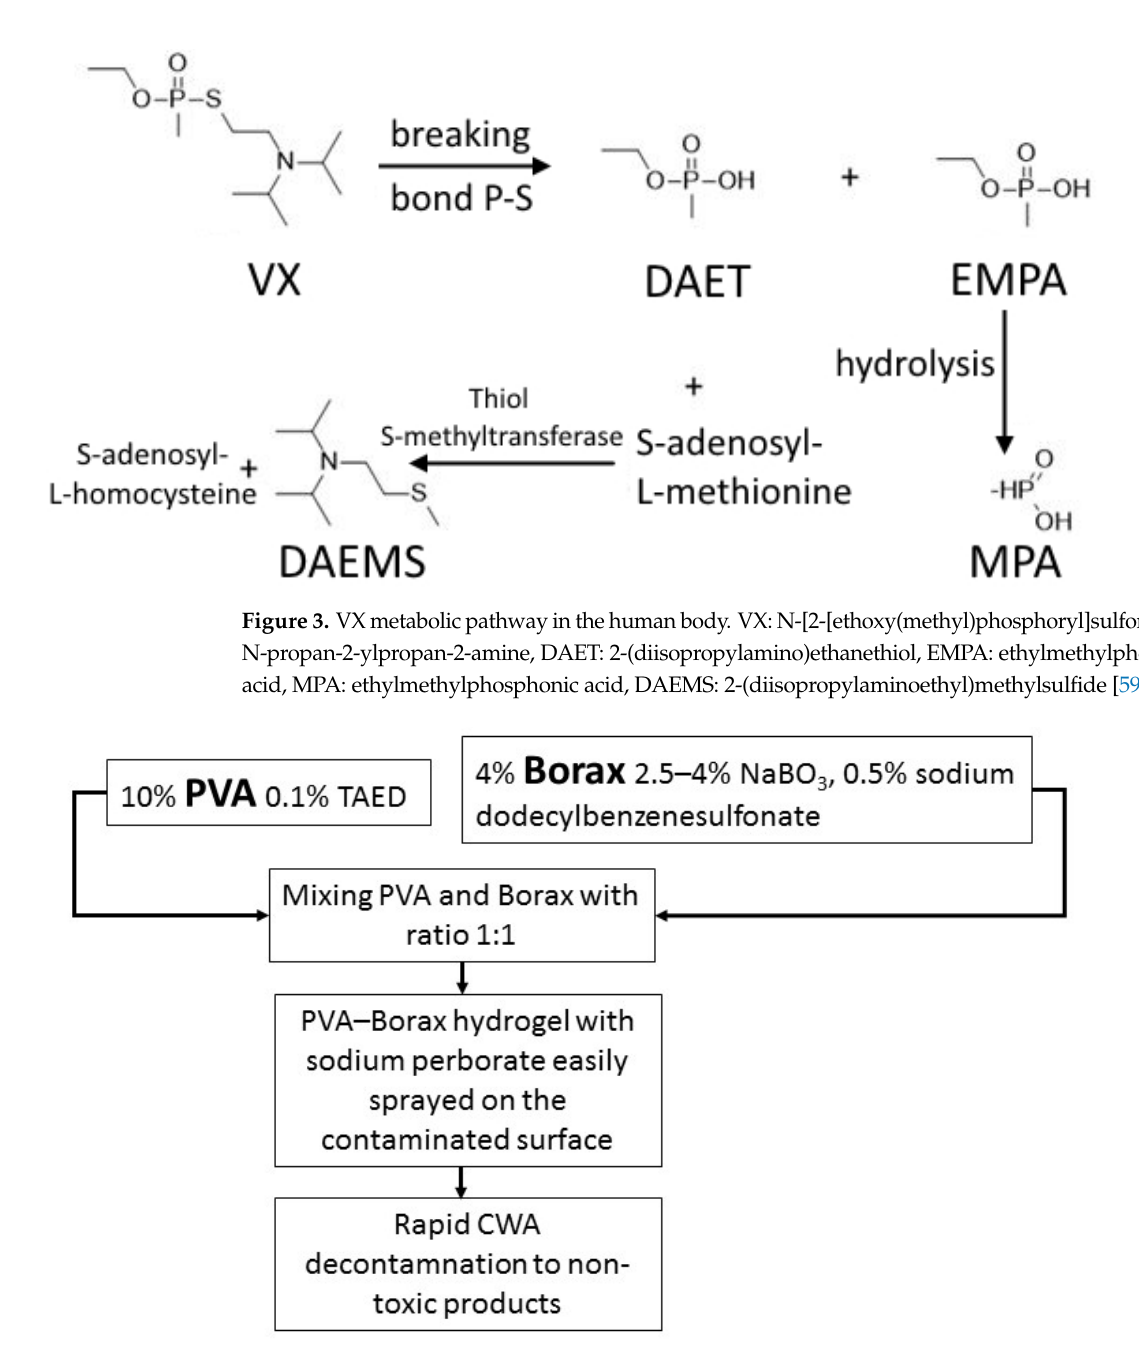
Table 5. Comparison of Polish and American standards in the treatment of poisoning with paralytic and convulsive factors in adults [67,68] . Hospital Treatment of Poisoning with Paralytic and Convulsive Factors in Adults Recommendations